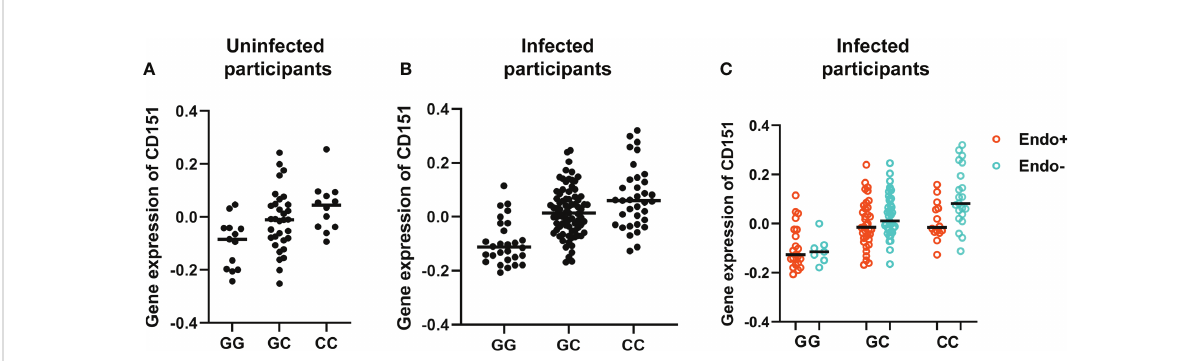
FIGURE 5 Genotype at the lead cis-eQTL rs10902226 at the CD151 locus is associated with altered expression of CD151 and risk of ascension. Using linear regression, in uninfected participants (A) , the SNP shows suggestive evidence to be an eQTL (P value = 0.0018), but it is not signi fi cant after multiple testing correction. In infected participants (B) , the SNP is a strong eQTL (P value = 6.7E-9) with an additive effect. In infected participants (C) , the effect of the C allele on CD151 expression and its relationship to endometrial infection can be visualized (P=0.012 by mediation test on this single SNP). This graph demonstrates that CC genotype is associated with increased CD151 expression and reduced occurrence of endometrial infection. In contrast, GG genotype is associated with lower CD151 expression and increased occurrence of endometrial infection. In all graphs, each dot represents one subject. The black line indicates the median expression of CD151 in each genotype group.